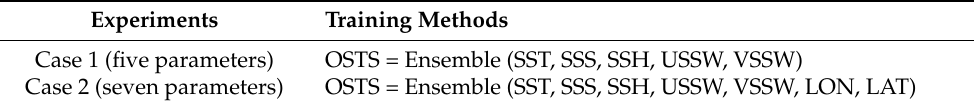
Table 4. Design of